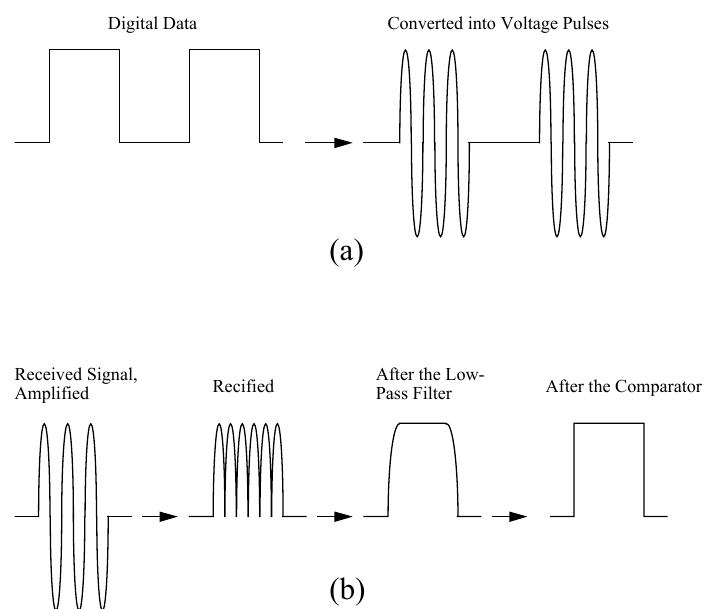
Figure 9. (a) Illustration showing how the digital data is converted into voltage pulses for transmission. (b) Illustration showing the conversion of the received signal to a digital bit. The as-received signal is first amplified and rectified. The high-frequency component of the rectified signal is filtered, and the digital state carried by the signal is extracted by passing through a comparator.